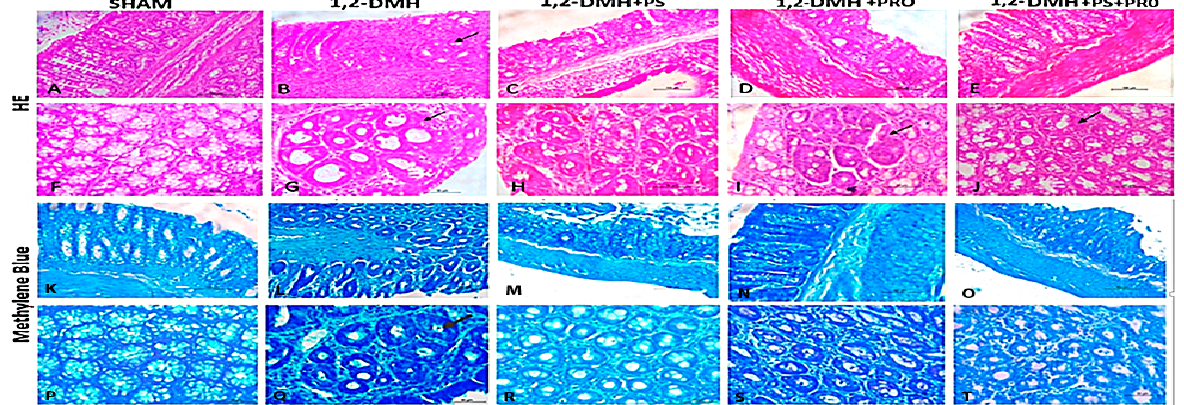
Figure 2. Histopathology of the experimental groups. Photos 2 ( A – E ) and 2 ( K – O ) were under 20 × objective magnification (scale bar 100 µ m) and the longitudinal section. Photos 2 ( F – J ) and 2 ( P – T ) were under 40 × objective magnification (scale bar 50 µ m) and the cross-section. Black arrow—the presence of an aggregate of ACF with more intense staining due to nuclear enlargement and mucin depletion.